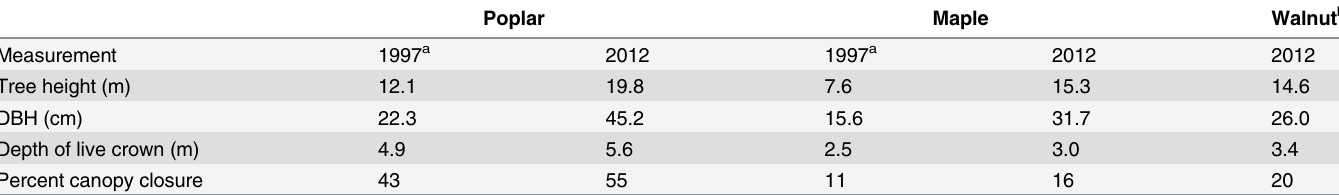
Table 1. 12 and 26-year-old trees (1997 and 2012, respectively) intercropped with soybean at the same study site.